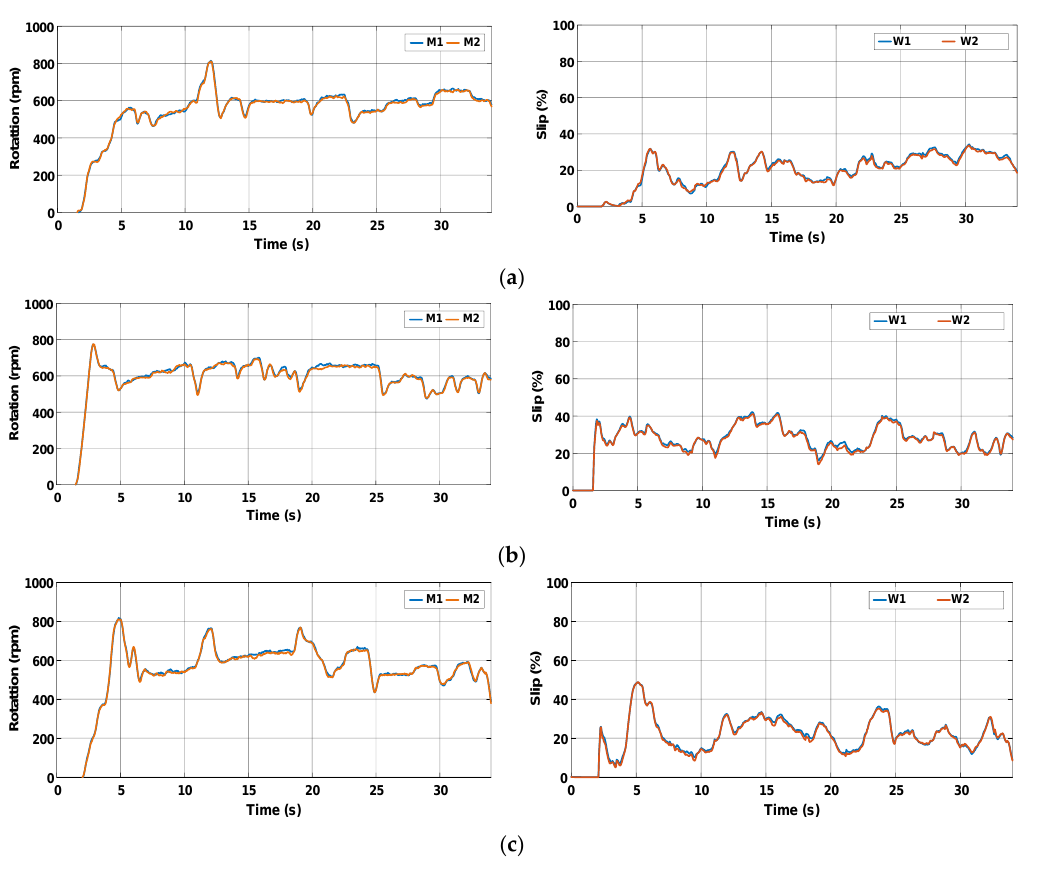
Figure 20. Rotation speed of electric motors and wheel slip during the trial sessions carried out on firm soil with the slip manually controlled by the operator. ( a ) T#2.1; ( b ) T#2.2; ( c ) T#2.3.